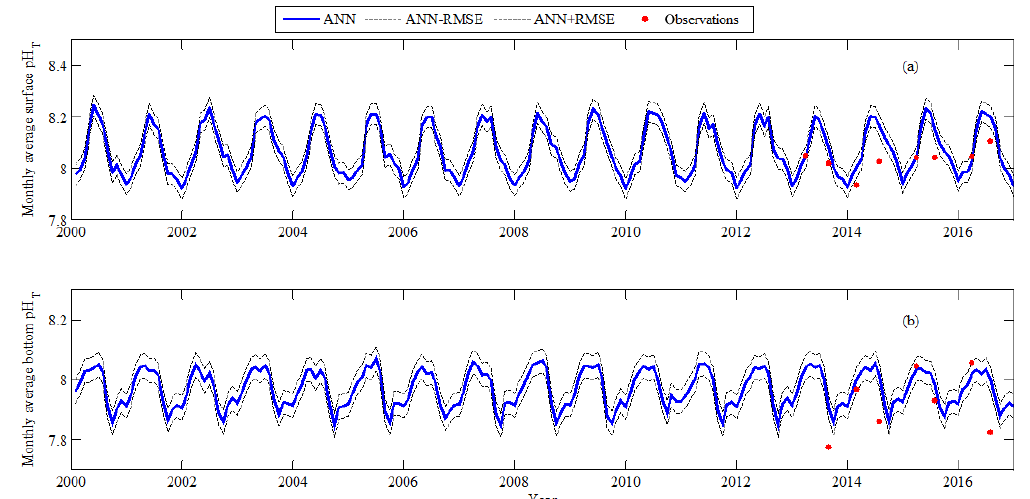
Figure 12. Comparison of monthly average pH T on the East China Sea shelf. Solid blue line represents retrieved pH T by the ANN model us- ing Changjiang biology FVCOM output, dotted black lines represent upper and lower bounds of the ANN model accuracy (ANN ± RMSE), and red points show monthly average pH T observations from 2013 to 2016. (a) Surface; (b)